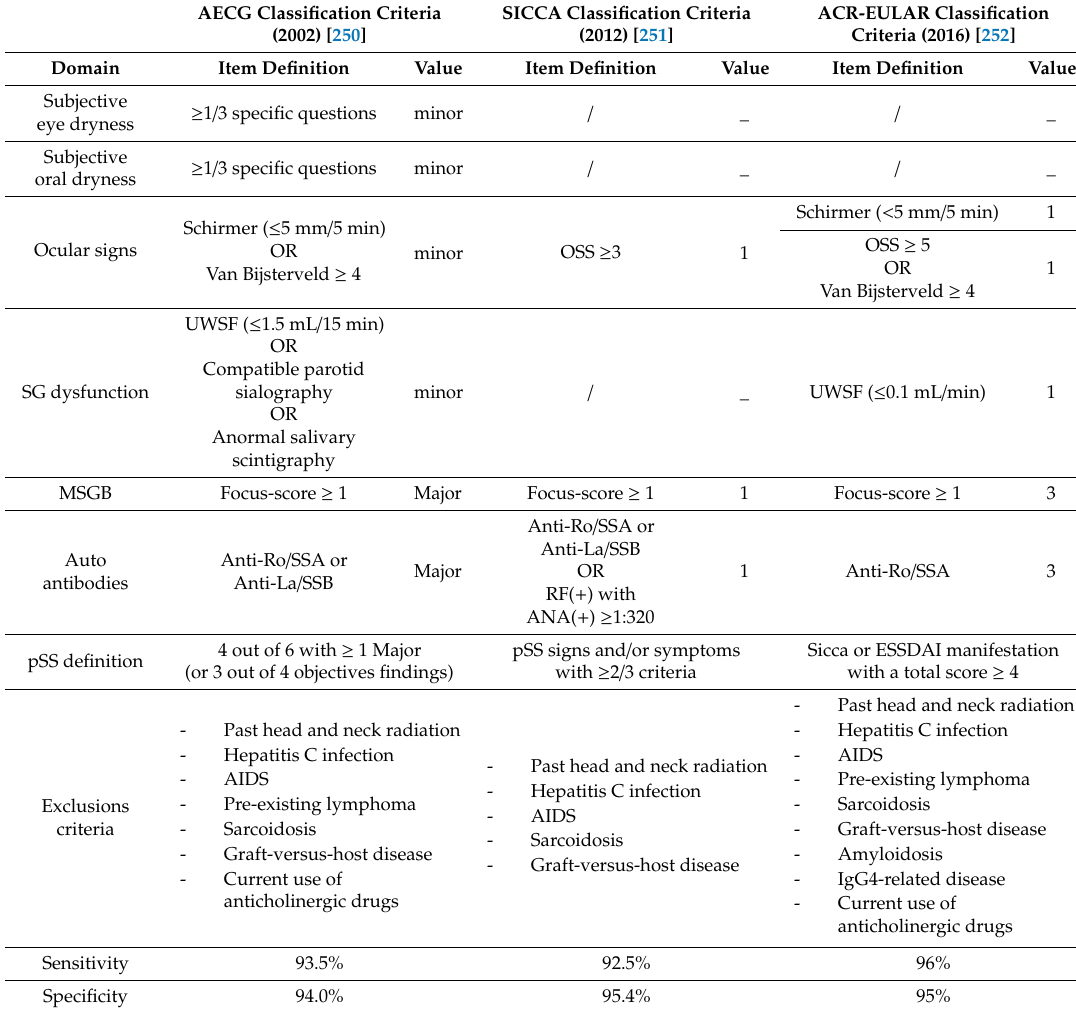
Table 2. Modern pSS Classification Criteria—comparisons of items, definitions and diagnosis performance compared to experts’